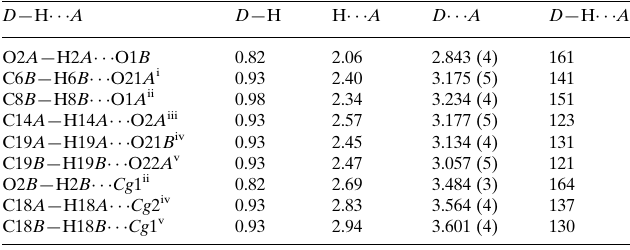
Hydrogen-bond geometry (A˚ , (cid:2) ). Cg 1 and Cg 2 are the controids of the C10 A –C15 A and C10 B –C15 B rings,